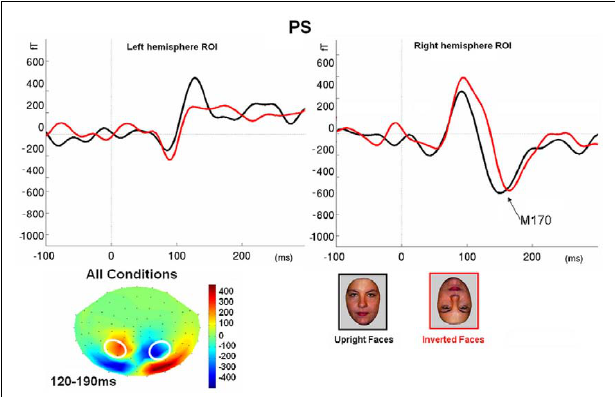
FIGURE 11 | Evoked responses averaged across three channels for the more superior left and right ROIs in Experiment 2 (see FigureA10 in Appendix for more inferior ROIs). These channels were chosen as those with the maximal negative deflection vs. baseline in the right hemisphere from 120 to 190ms, averaged across conditions, highlighted in white on topography below (these are Neuromag channels “MEG2441,” “MEG2311,” and “MEG2231” for the right ROI, and “MEG1841,” “MEG1631,” and “MEG1911” for the left